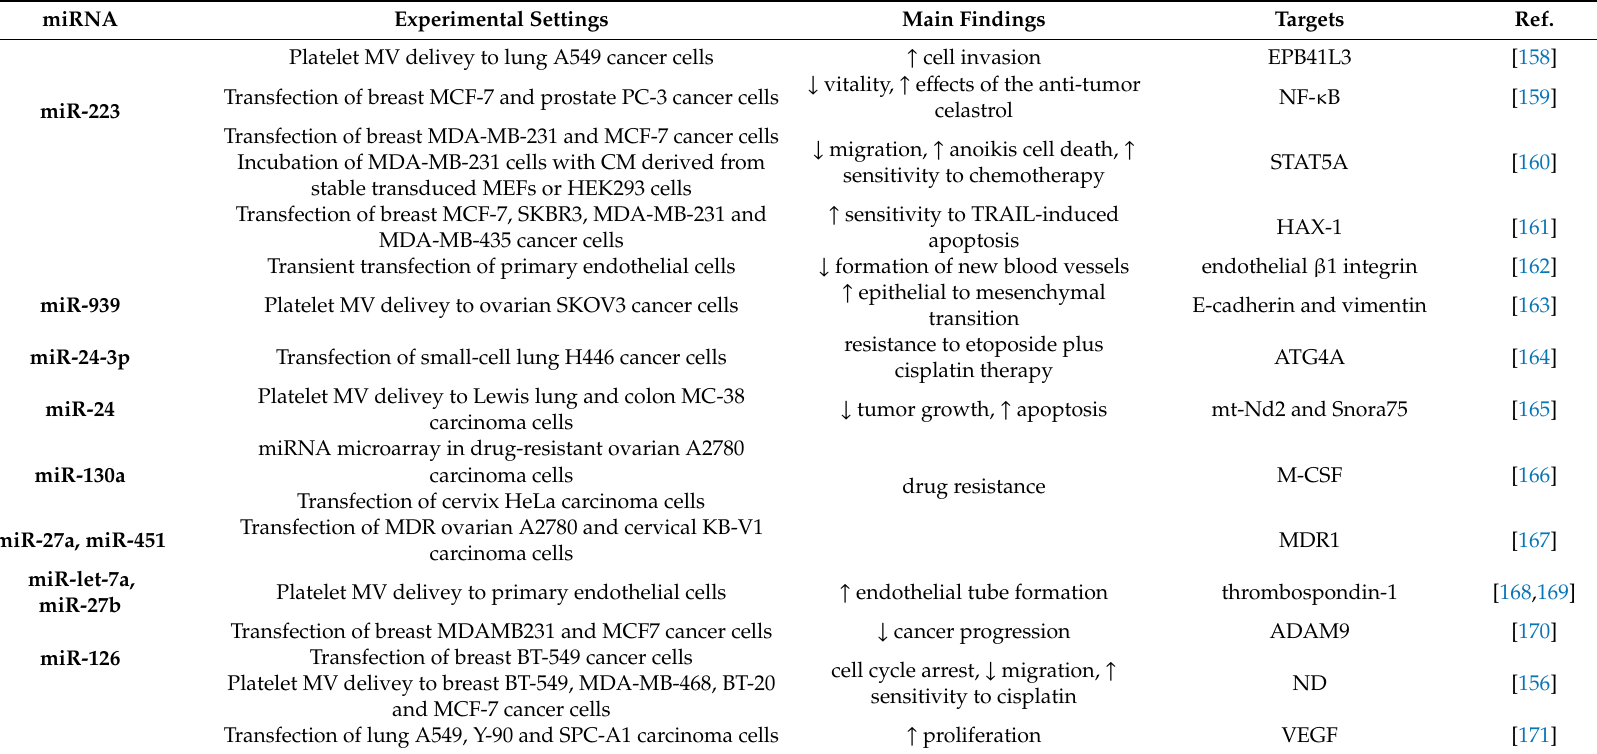
Table 3. Main findings on the cancer-related role of miRNAs, potentially delivered by platelet MVs.